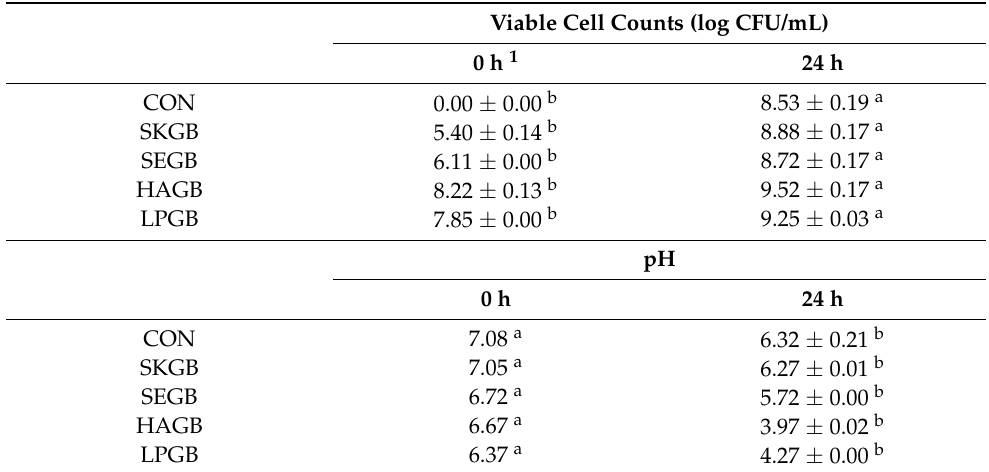
Table 1. Change of viable cell counts and pH during Gryllus bimaculatus (GB) fermentation.